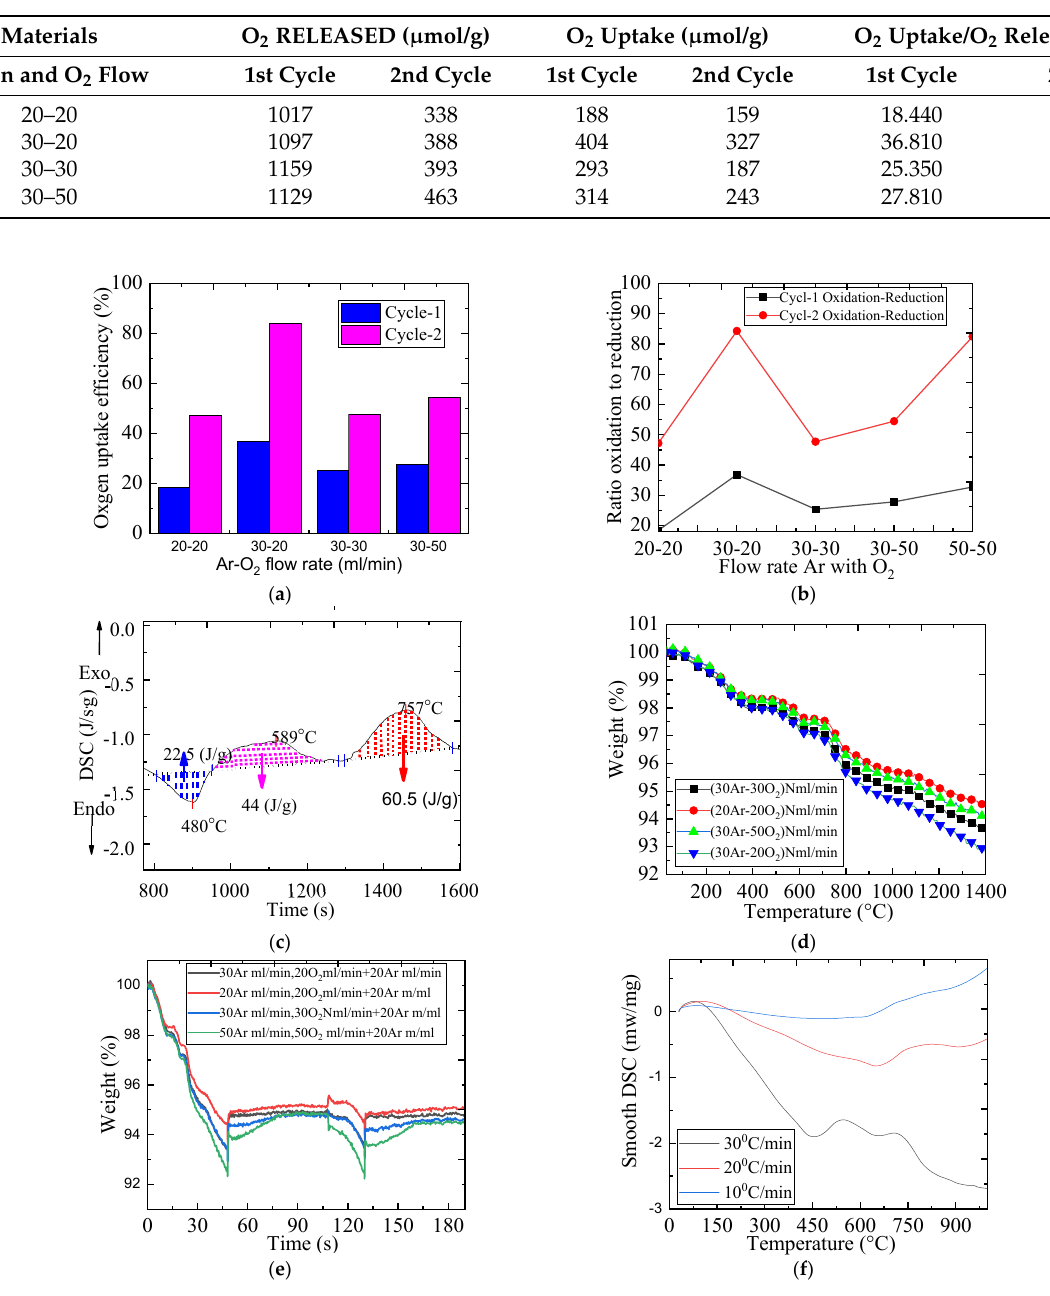
Table 4. Gas flow rate and O 2 storage capacity.